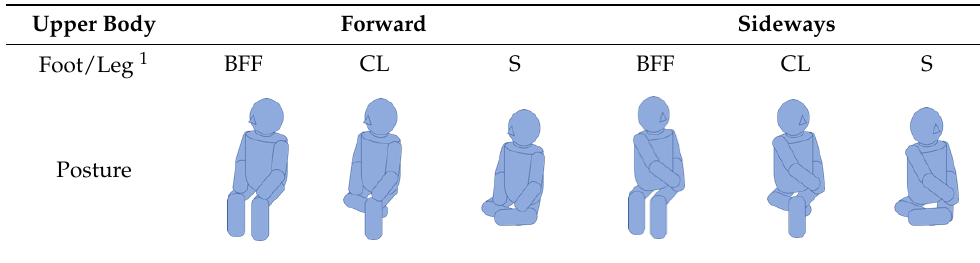
Table 2. Posture parameters.